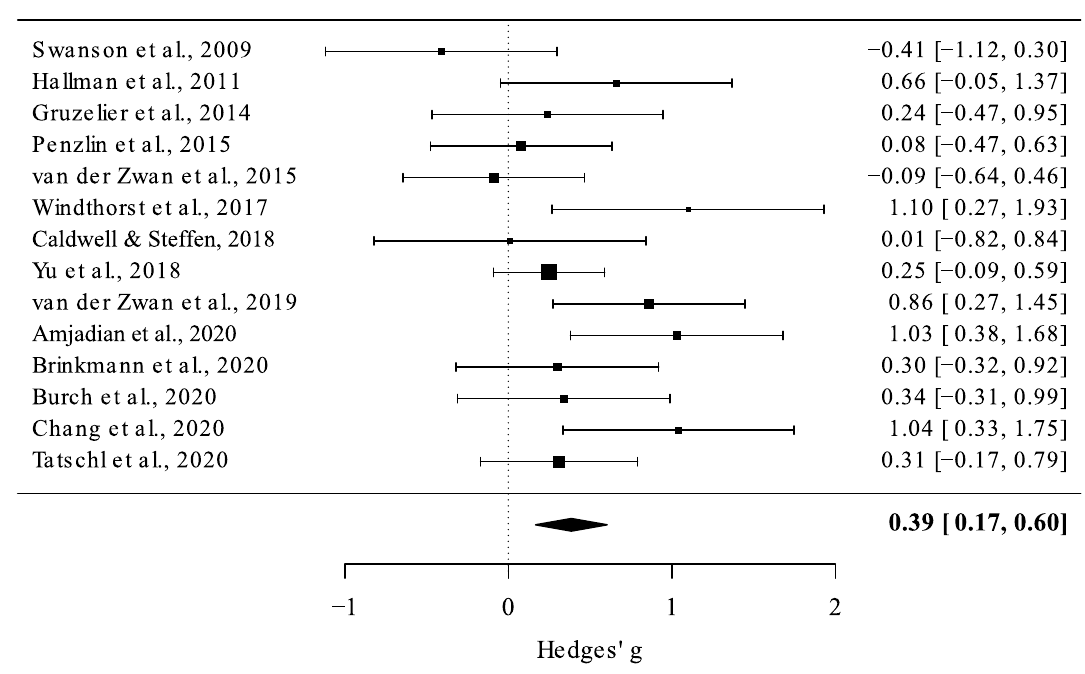
Figure 3. Forest plot, each square corresponds to one study and the lines represent 95% confidence interval. The size of each square represents the weight of the study. The diamond at the bottom represents the cumulative effect size with 95% confidence interval. Higher positive values indicate greater effect of the HRVB intervention compared with the control group.